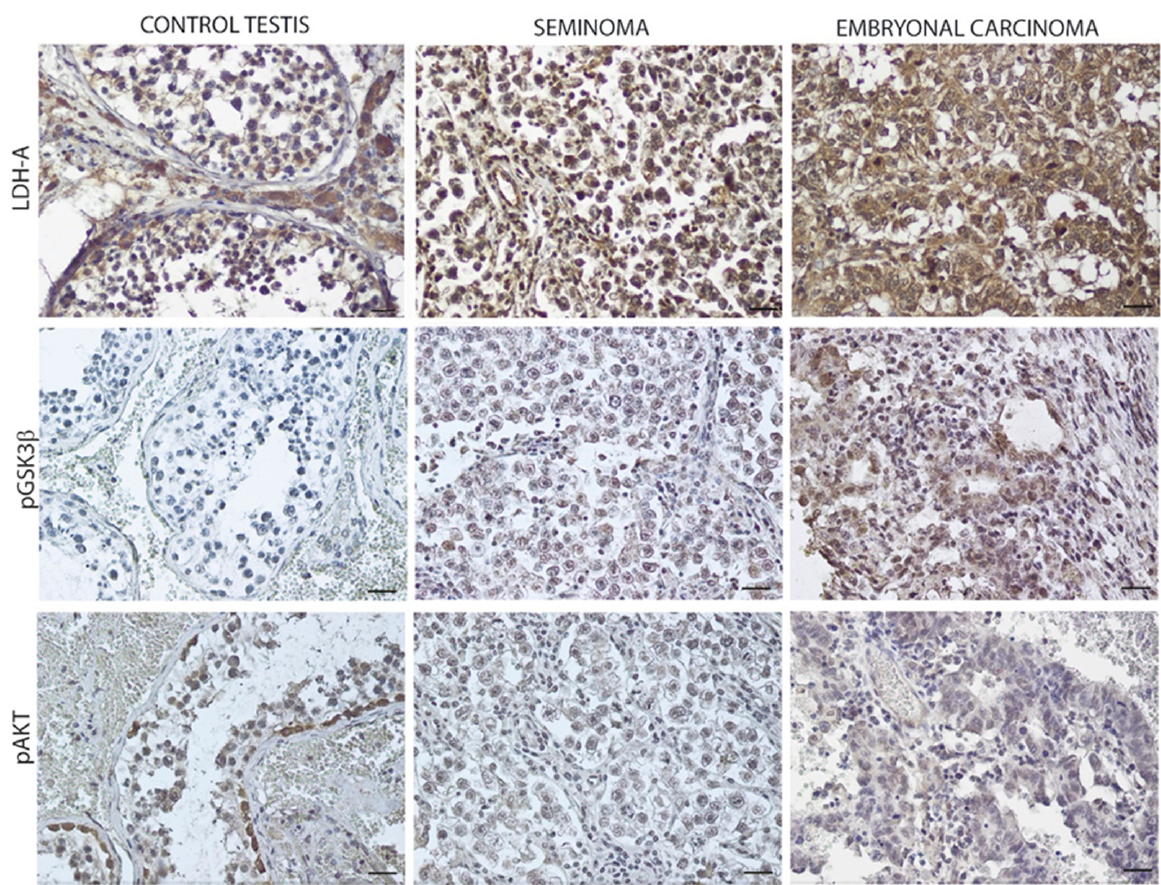
Figure 4. LDH-A expression in control testis and TGCTs. Scale bars: 25 µ m. Lactate dehydrogenase- A (LDH-A); phospho-Glycogen synthase kinase 3 β (pGSK-3 β ); phospho- protein kinase B (pAKT. Table 3. LDH-A and PI3K pathways in control and TGCTs.